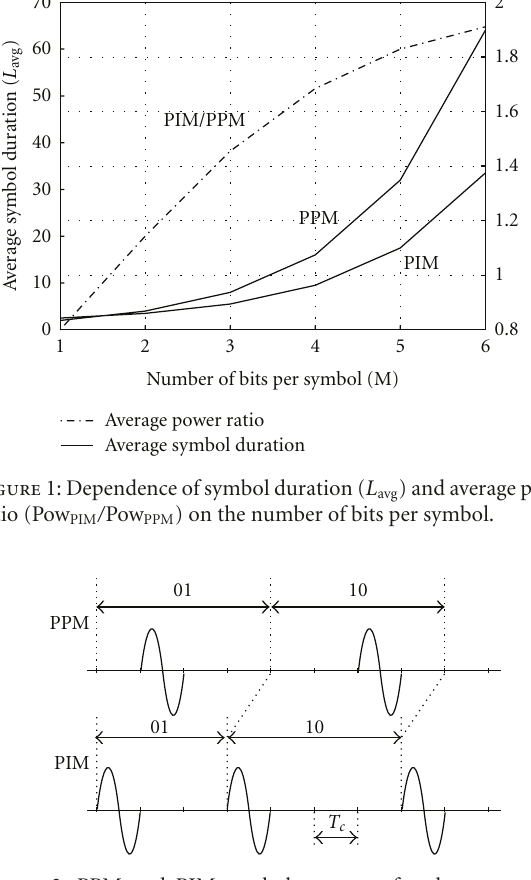
Figure 2: PPM and PIM symbol structure for the sequence of source bit combinations 01 and